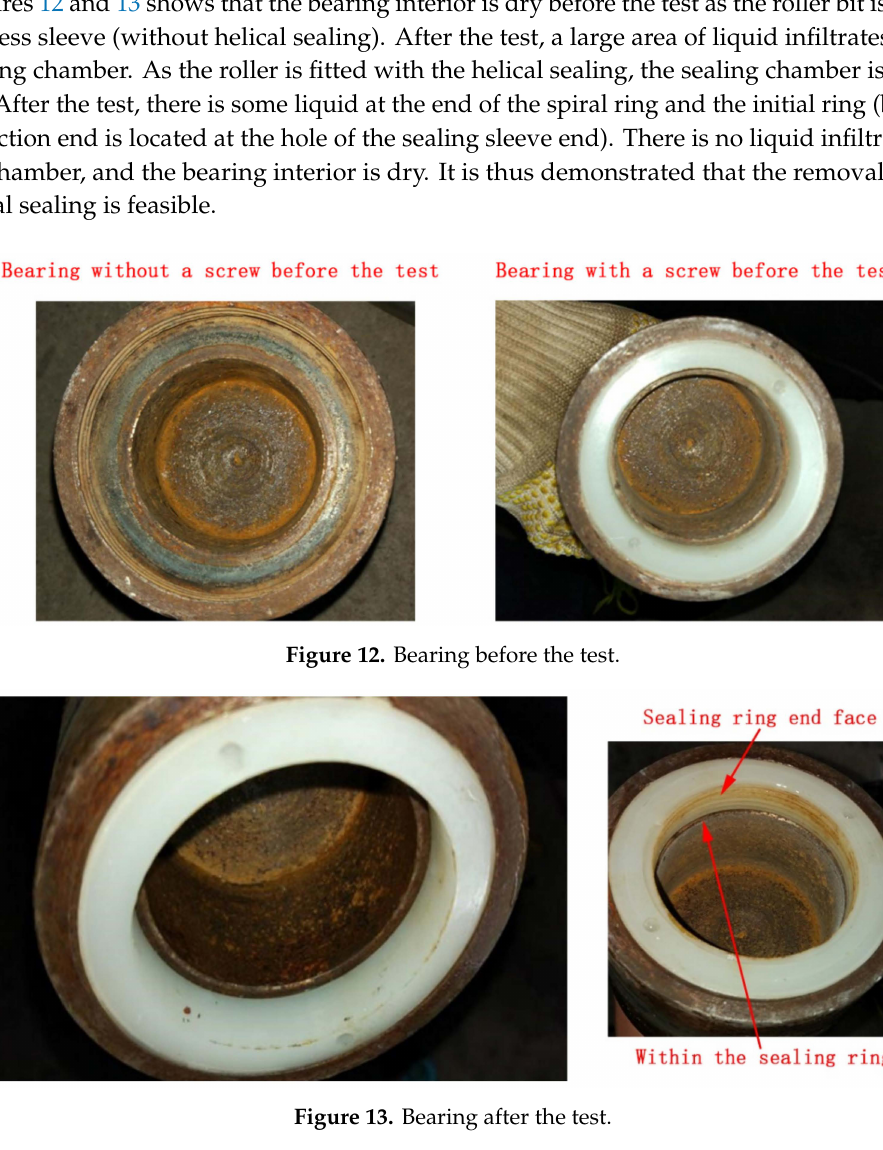
Figure 13. Bearing after the